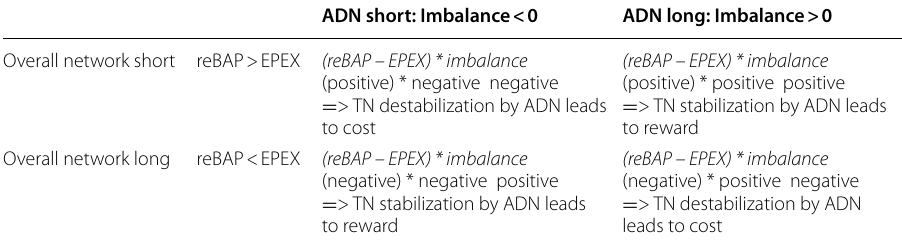
Table 2 Costs/rewards from imbalance charges under German regulation depending on the ADN/ network